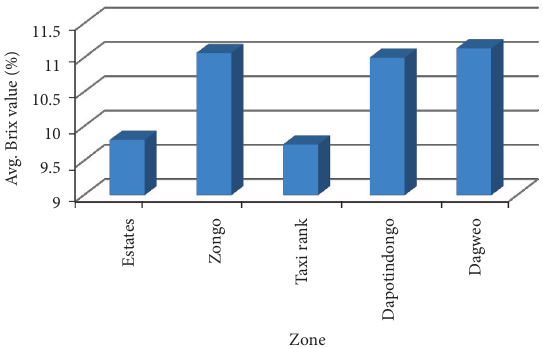
Figure 7: Average zonal percentage Brix